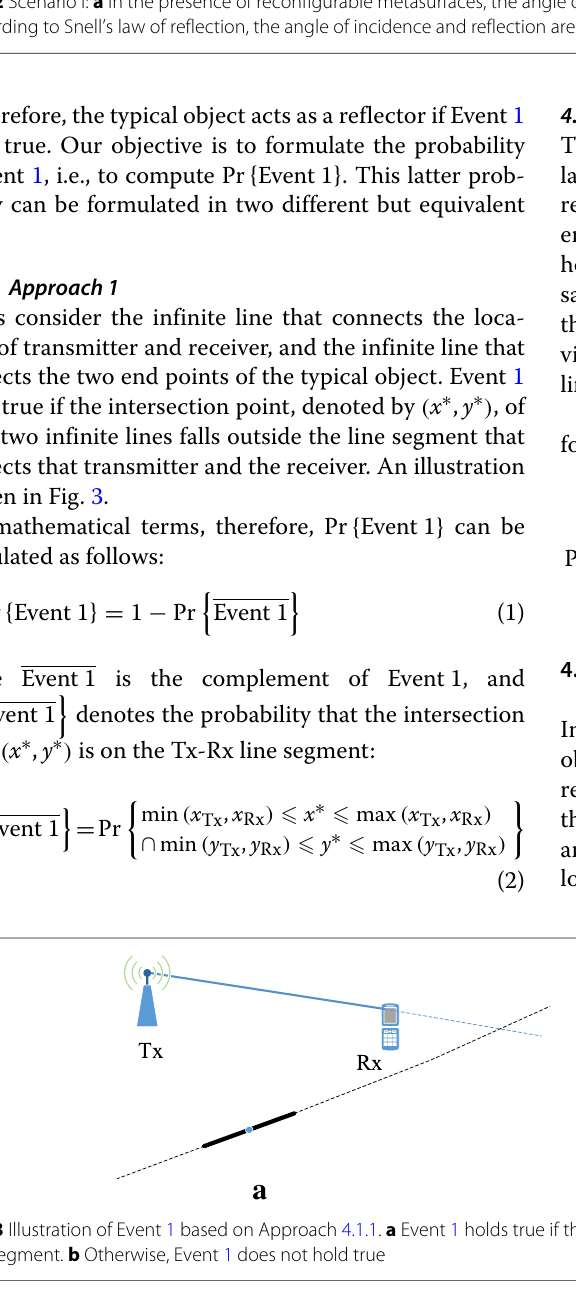
Therefore, the typical object acts as a reflector if Event 1